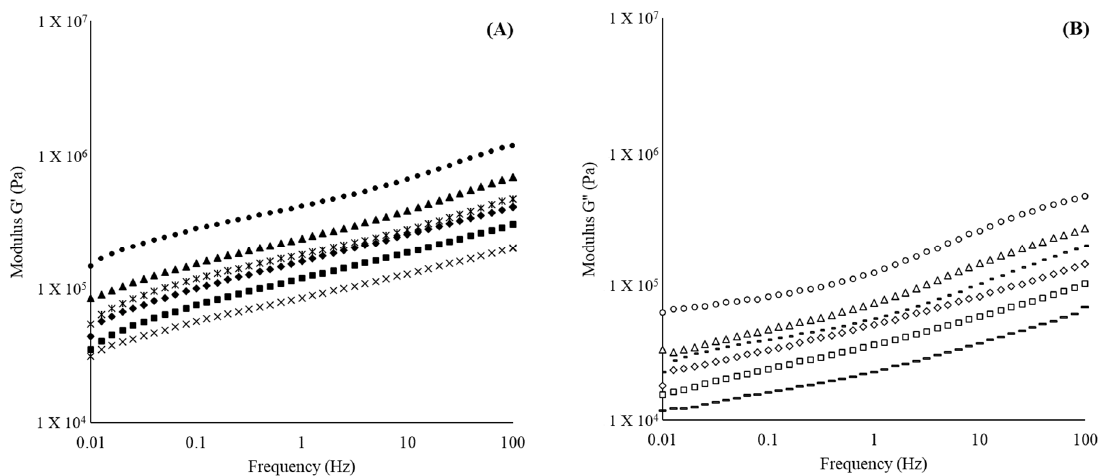
Figure 3. Frequency sweep in experimental costeño-type cheese. ( A ) The storage modulus (G’) for the cheeses Q C (black circles), Q 1 (black squares), Q 2 (black diamonds), Q 3 (crosses), Q 4 (black diamonds) and Q 5 (asterisks), and ( B ) loss modulus (G´´) for the cheeses Q C (white circles), Q 1 (white squares), Q 2 (white diamonds), Q 3 (short dashes), Q 4 (white triangles) and Q 5 (long dashes).